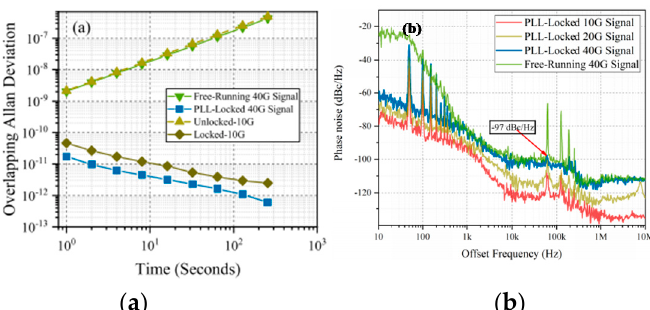
Figure 17. ( a ) The overlapping Allan deviation of the OEO system. ( b ) Comparison of phase noise for the OEO system. Reprinted with permission from Ref. [53], OSA, 2018 .